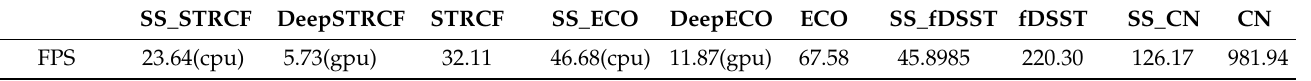
Table 2. FPS of our SSCF and their corresponding baseline trackers.